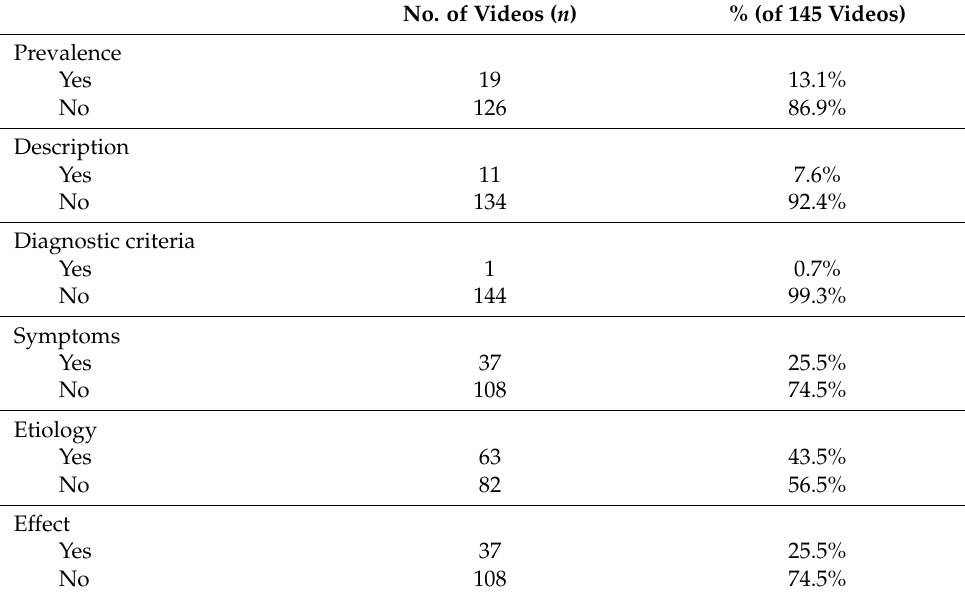
Table 3. General information on dental fear, dental anxiety, and dental phobia.